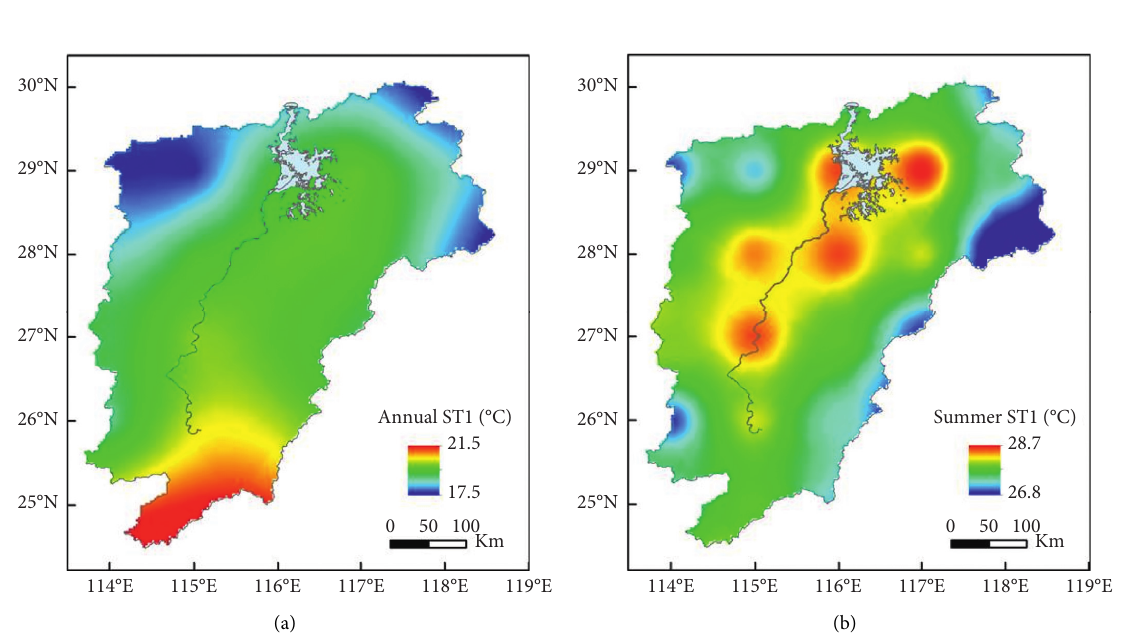
Figure 6: Spatial distribution of annual soil temperature (a) and summer soil temperature (b) of ST1 over the Poyang Lake